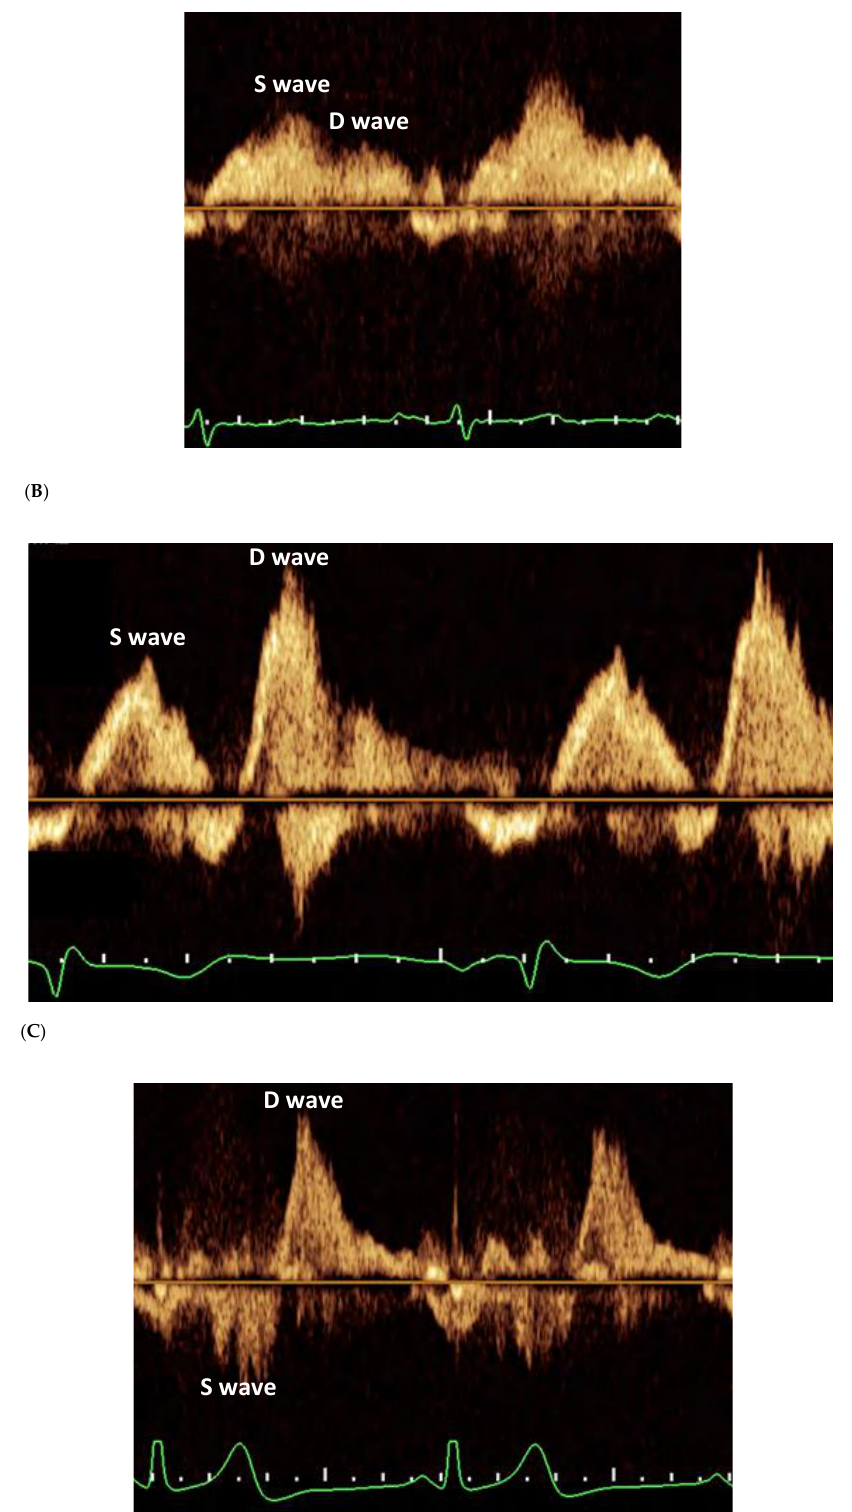
Figure 1. Pulmonary Venous Flow Patterns as Imaged on Transesophageal Echocardiogram. Normal pattern is signified by a peak systolic (S) to peak diastolic (D) flow velocities ratio of ≥1. Abnormal pattern may include either a blunted or a reversed S wave, manifested by an S/D ratio of <1 or <0, respectively. ( A ) Normal Flow Pattern. ( B ) Blunted Flow Pattern. ( C ) Reversed Flow Pattern. The study cohort was split into three main groups according to baseline PVFP, namely normal, reversed, and non-reversed, with the latter comprising patients exhibiting either normal or blunted flow patterns in the PVs. In each group, continuous variables were expressed as means and standard deviations (SDs) or as medians and interquartile ranges (IQRs). Categorical variables were reported as frequencies and percentages. Be- tween-group comparison of continuous variables with normal distribution was per- formed using Student’s t test, while that of continuous variables demonstrating non -nor- mal distribution was performed using the Mann – Whitney U test. Categorical variables were compared using Pearson’s chi-squared test or Fisher’s exact test. Importantly, only two groups were compared at a time. The risk for the development of the primary outcome according to PVFP was graph- ically displayed using the Kaplan – Meier method, with comparisons of cumulative sur- vival across strata conducted using the log rank test. To identify independent associations between the primary outcome and baseline variables, particularly different forms of PVFP, univariable Cox regression analysis was employed, after which parameters show- ing a p -value of <0.1 were integrated into a multivariable model. Patients with missing data were censored from the relevant analyses. A two-sided p - value of <0.05 was considered to represent statistical significance. All analyses were per- formed using SPSS TM Statistic for Windows software, version 24 (IBM Corporation, Ar- monk, NY, USA). 3. Results 3.1. Baseline Characteristics of the Study Population Out of 485 patients that underwent TEE for an evaluation of chronic dMR at RMC between May 1995 and June 2017, a total of 135 met the study inclusion criteria (Figure 2).